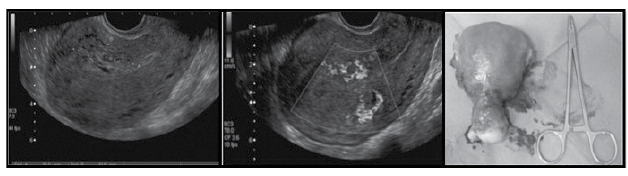
figurE 2 – Gynecologic ultrasound image and surgical specimen of the clinical case (Hospital Prof. Dr. Fernando Fonseca, Amadora, Portugal) In the gynecologic ultrasound image, a hypervascularized central area of heterogeneous structure is visible, infiltrating the anterior and posterior wall of the uterine myometrium. Surgical specimen of hysterectomy with conservation of